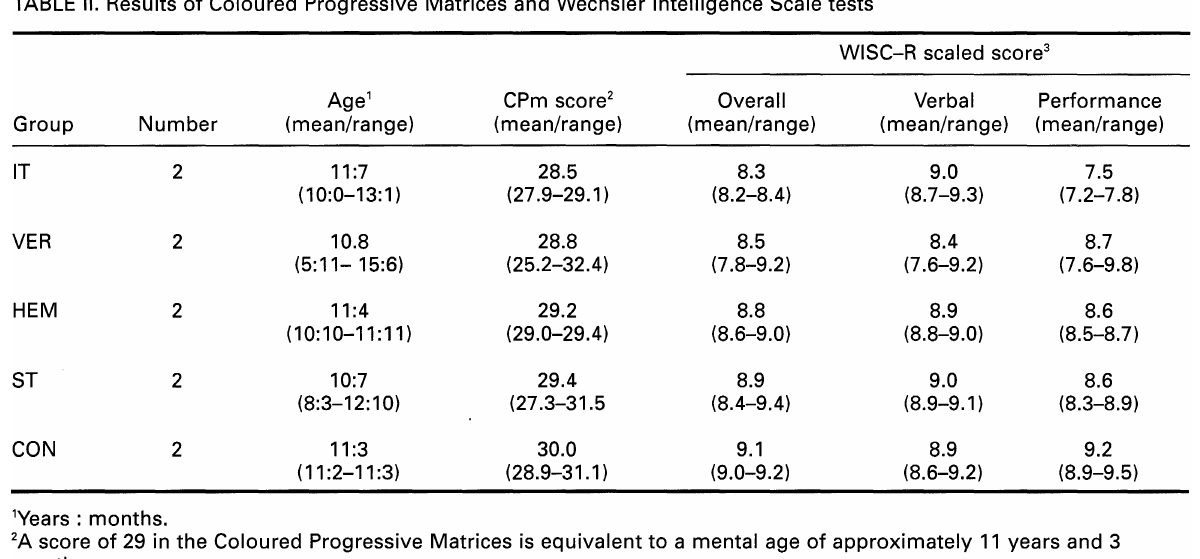
TABLE II. Results of Coloured Progressive Matrices and Wechsler Intelligence Scale